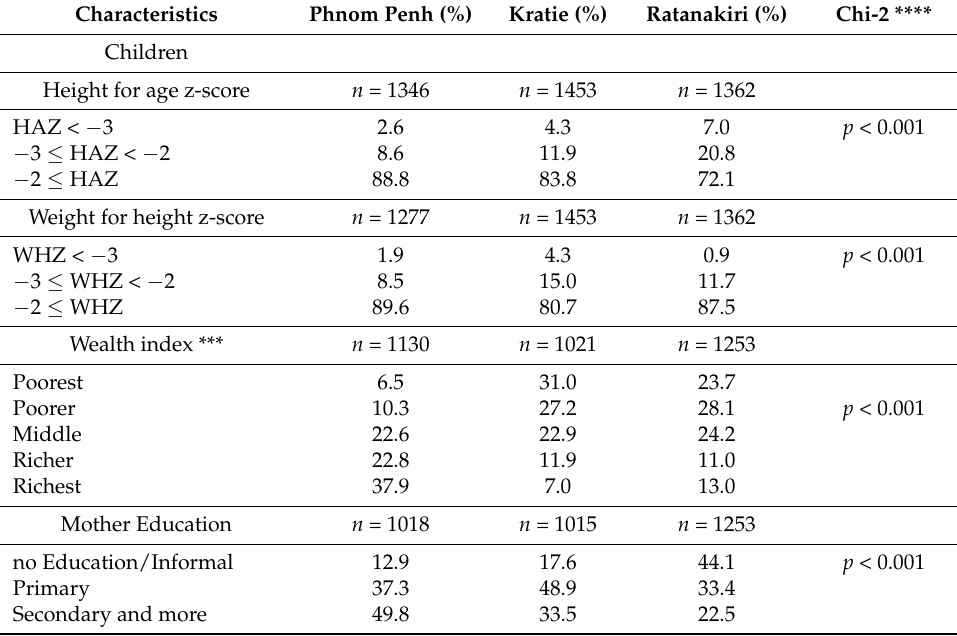
Table 1. Characteristic of the